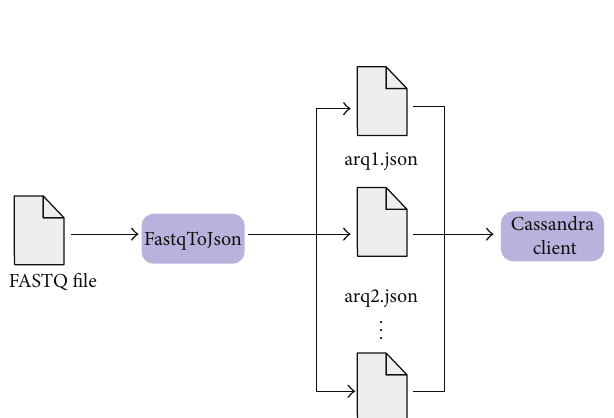
Figure 1: Database schema.